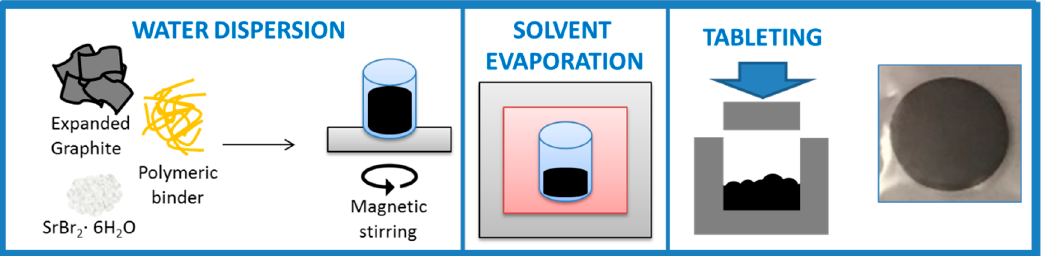
Figure 1. Thermochemical material (TCM) composite material manufacturing process.